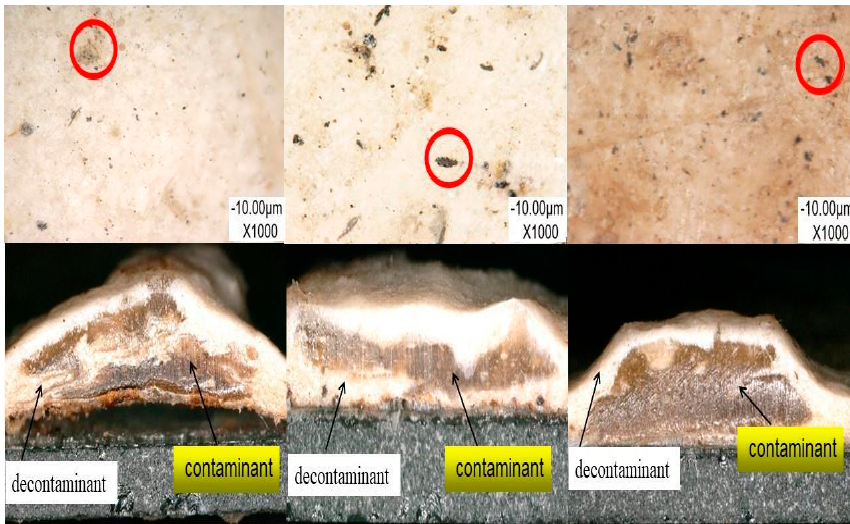
Figure 13. View images of samples. Membrane cross-section: Frozen slice samples were obtained using a Leica-cm-1520 from Leica, sectioned at − 20 °C. The samples were fixed on the tray using a fixative, and the cross-section was facing upward.